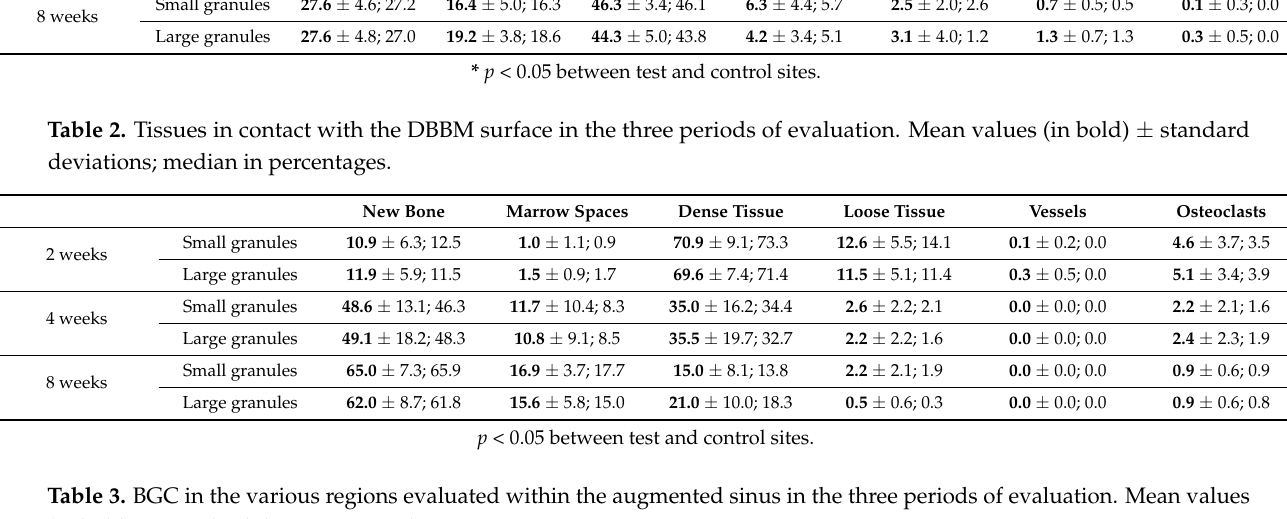
Table 3. BGC in the various regions evaluated within the augmented sinus in the three periods of evaluation. Mean values (in bold) ± standard deviations; median in Close window p < 0.05 between test and control sites.